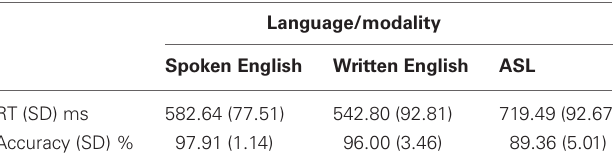
Table 1 | Mean reaction time and accuracy data across languages/modalities.